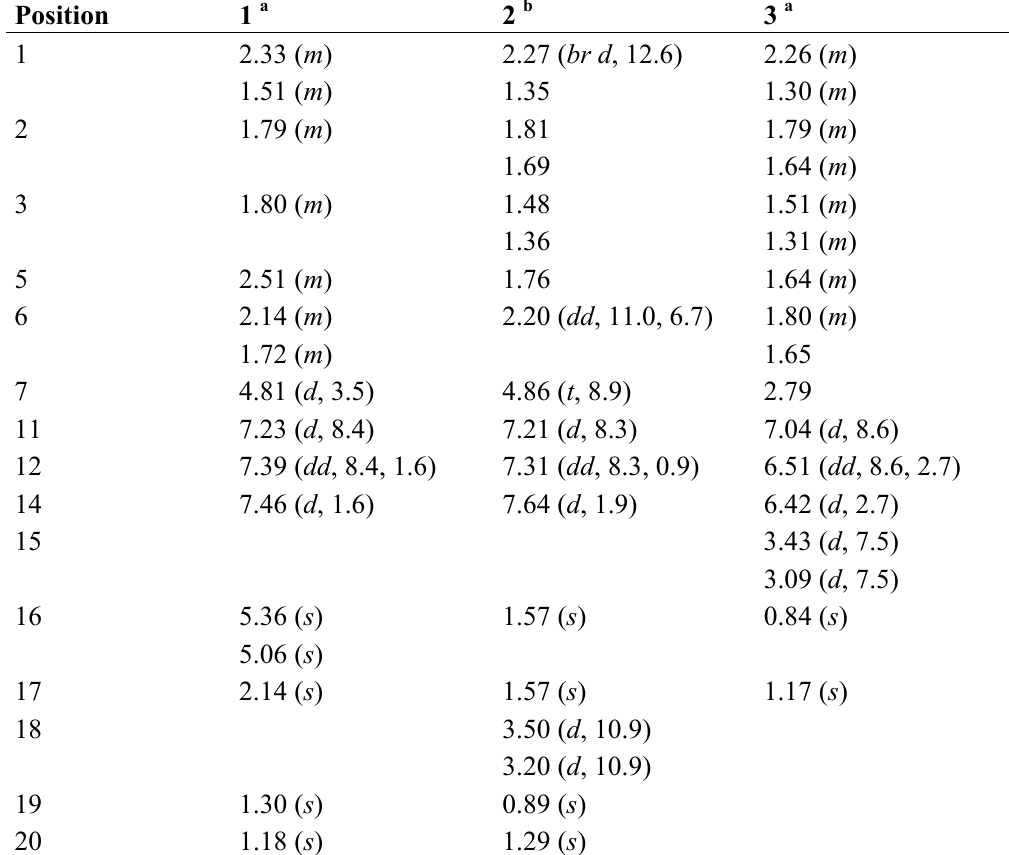
, b in CD OD, J in Hz). 3 3